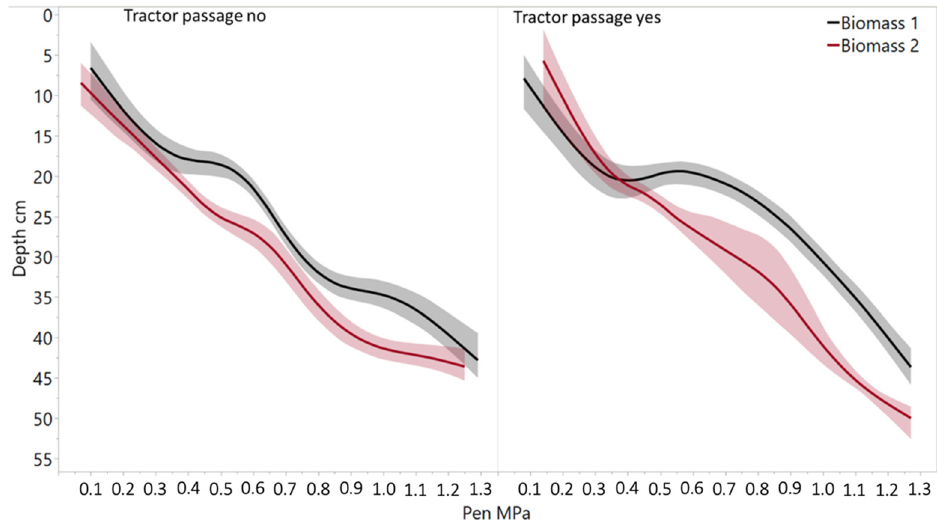
Figure 6. Penetration resistance curve in relation to depth differentiated by type of area and tractor passage. A cubic spline smoother with lambda = 0.05, with standardised x-values, and 95% confidence interval.